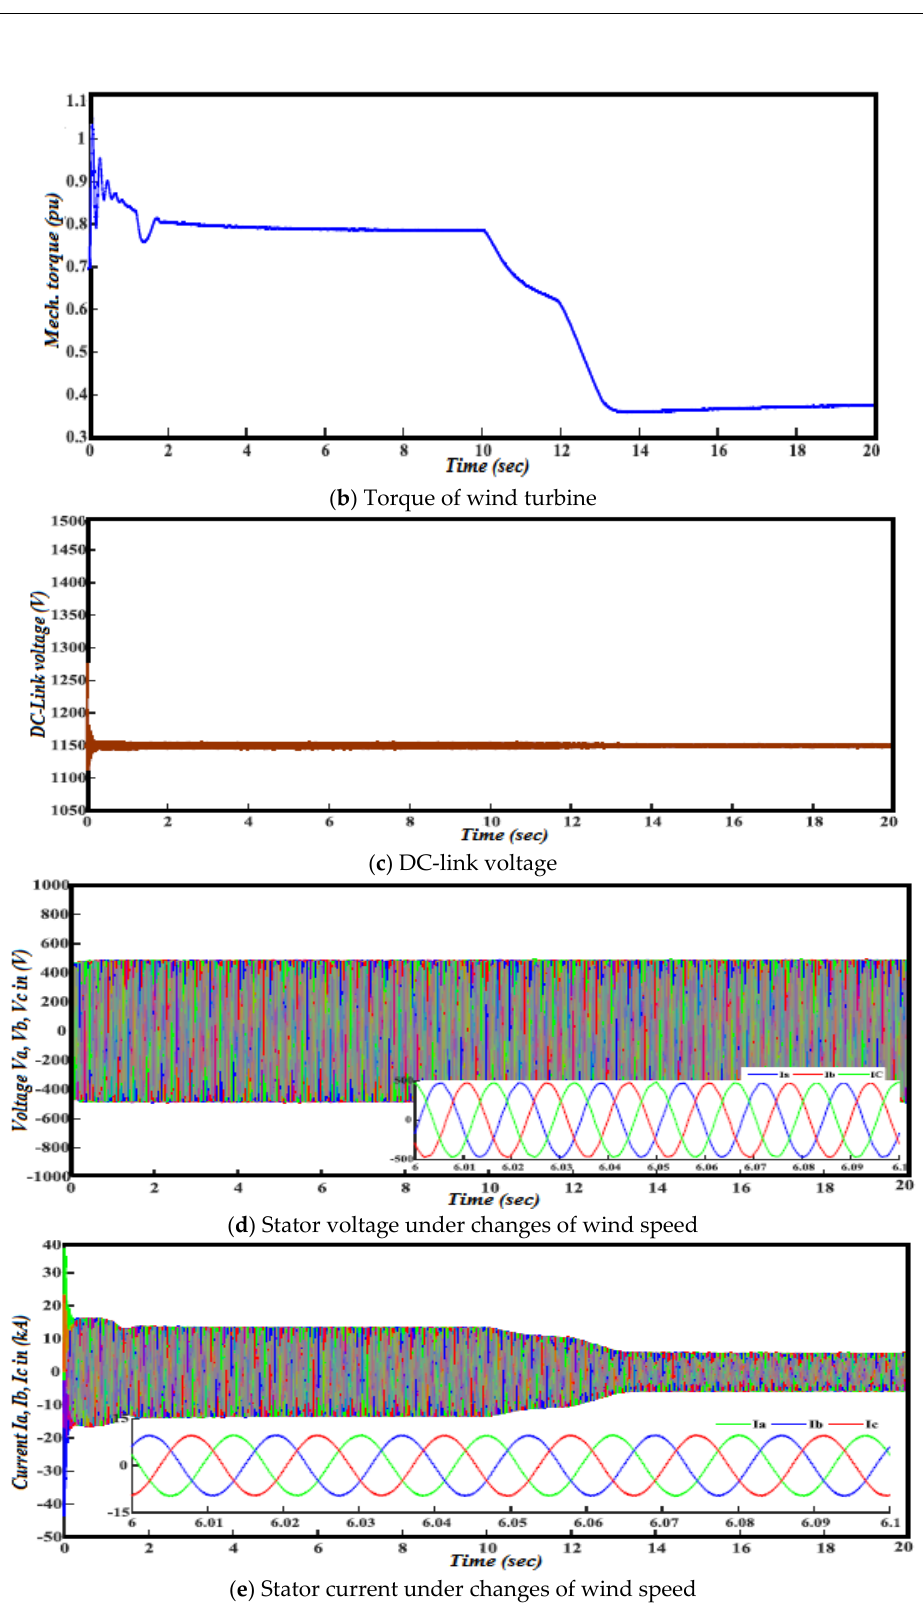
Figure 16. Performance of DFIG